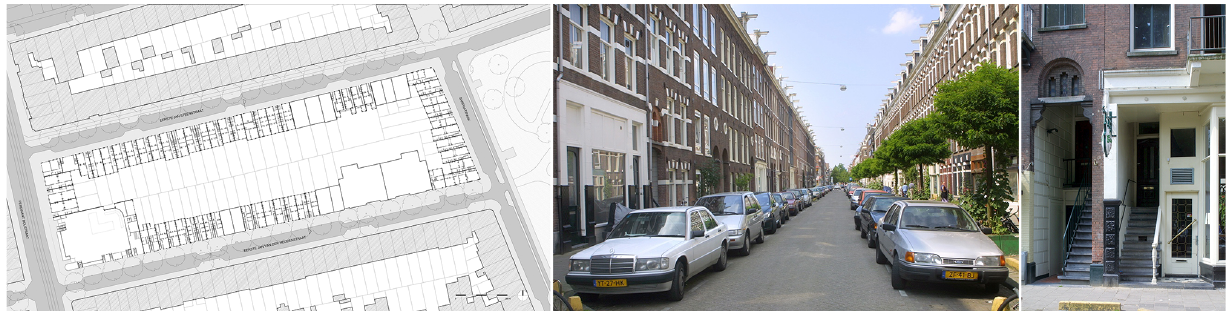
Figure 1. De Pijp, Amsterdam. From left to right: Ground floor plan 1:500; housing area, typical street view with 19th century stacked housing; access system directly from the street. Source: Authors. centre are lined with shops and very carefully arranged.